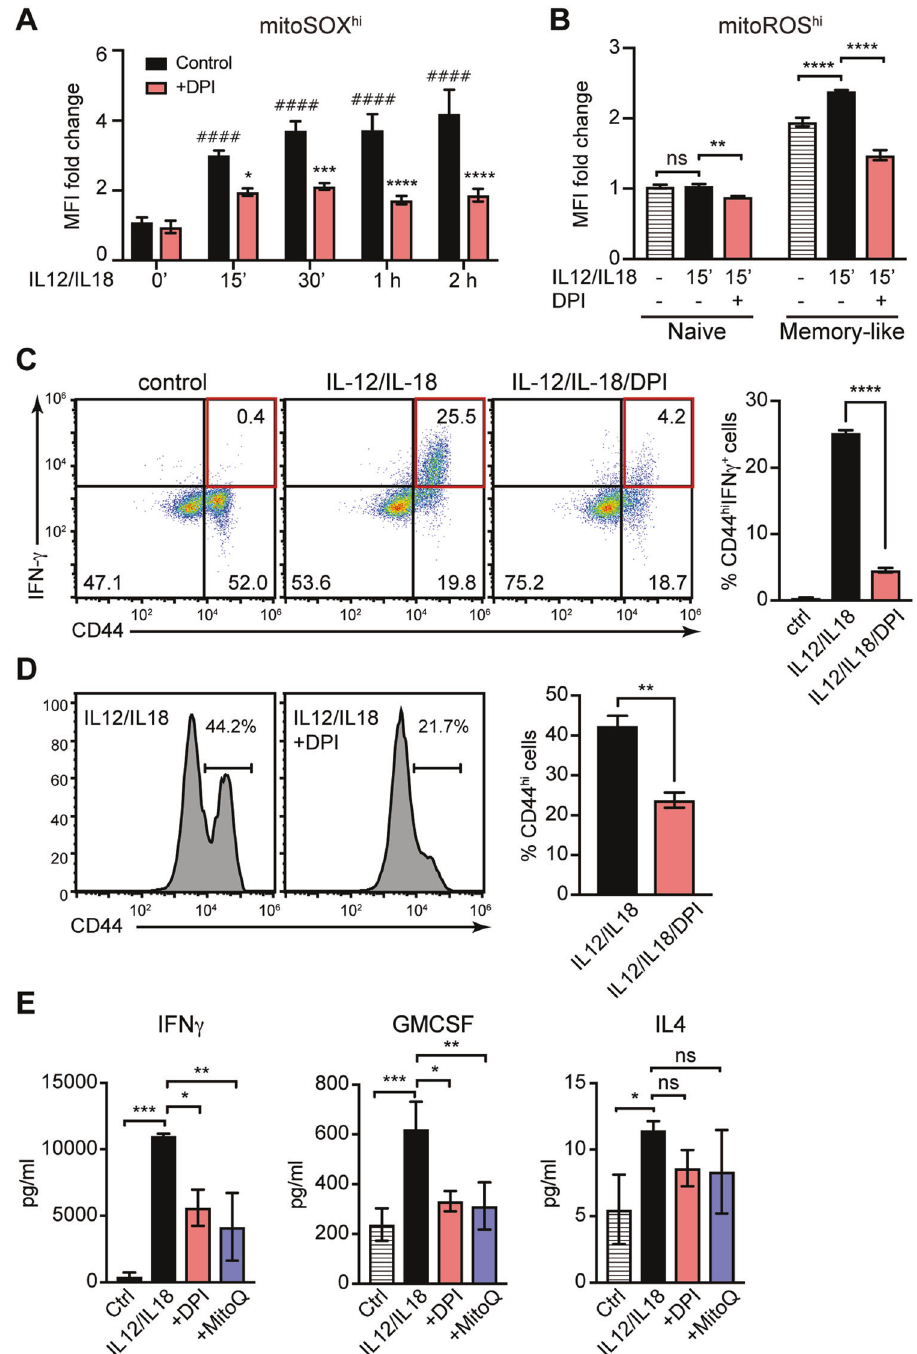
Fig. 2 DPI treatment lowers mROS and IFN- γ production in differentiated memory-like CD4 + T cells. In vitro differentiated memory-like CD4 + T cells (as in Fig. 1) were stimulated with IL-12/IL-18. A MitoSOX red fl uorescence analyzed by fl ow cytometry showing mROS production in the early time points of IL-12/IL-18 or IL-12/IL-18 + DPI treatment. Statistical signi fi cance is represented by symbols # for MFI increase after stimulation compared to 0 time point, or * for MFI decrease after DPI treatment compared to untreated control of each time point. B Flow cytometry analysis of mROS production using MitoROS dye in naïve vs . memory-like cells at 15 min after treatment with IL-12/IL-18 or IL-12/IL- 18 + DPI. C Left , Intracellular staining showing the frequency of IFN- γ -producing CD44 hi effector/memory T cells at 24 h after IL-12/IL-18 or IL- 12/IL-18 + DPI treatment in CD4 + cells. Right , Statistical analysis of observed differences. D Flow cytometry analysis showing surface expression of CD44 at 24 h after IL-12/IL-18 or IL-12/IL-18 + DPI treatment. E Cytokine secretion at 4 h after IL-12/IL-18 treatment in presence of DPI or MitoQ. Pseudo-color plots and histograms are representative of at least three experiments performed. Statistical signi fi cance was estimated using unpaired Student ’ s t test D , one-way ANOVA with post-hoc Tukey test ( C , E ) or two-way ANOVA with Sidak ’ s correction for multiple comparison A , B . Graphs show mean ± SD ( n = 3 different mice); * p < 0.05; ** p < 0.01; *** p < 0.001; **** p < 0.0001.